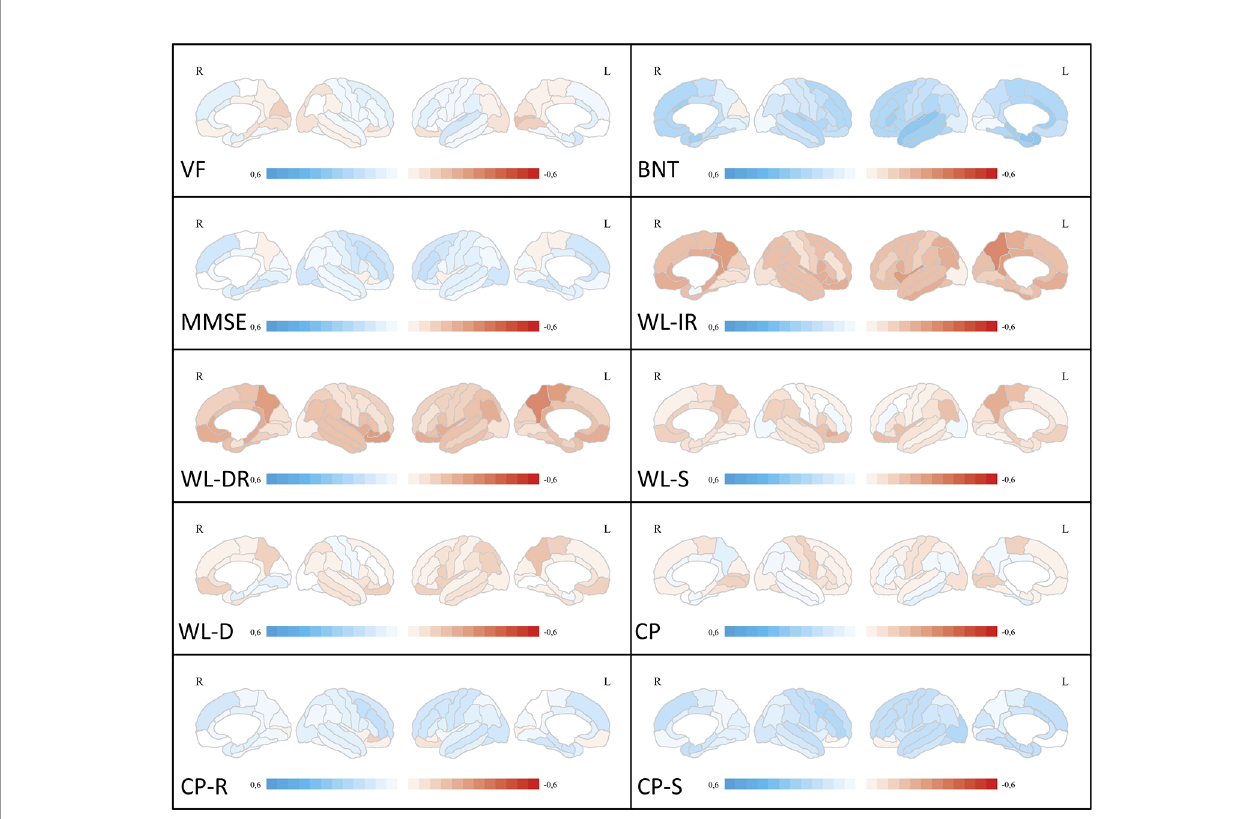
FIGURE 1 | Correlation analyses between ROI-based amyloid deposition and neuropsychological test scores. Medial and lateral projections of the right and left hemisphere are shown. Red color depicts negative correlations (Pearson ’ s r), blue color depicts positive correlations. Maximum Pearson ’ s r is set at -0.6 and 0.6, respectively. Verbal fl uency (VF), Boston Naming Test (BNT), Mini-Mental State examination (MMSE), Word List Immediate Recall (WL-IR), Word List Delayed Recall (WL-DR), Word List Savings (WL-S), Word List Discriminability (WL-D), Constructional Practice (CP), Figures Recall (CP-R), Figures Savings (CP-S). ROI, region of